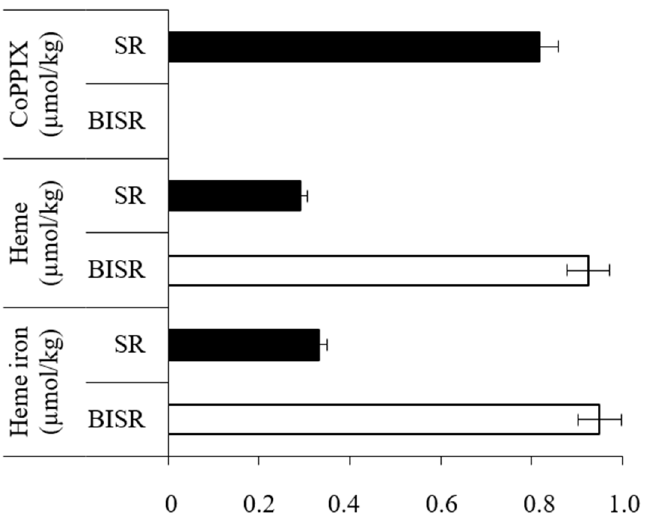
Figure 2. Concentration of CoPPIX, heme and heme iron in BISR and SR samples (µmol/kg of rock sample). Selected ion ( m / z 621) gas chromatogram of CoPPIX and calibration curve for determining the concentration of CoPPIX are presented in Figures S1 and S2, respectively. HPLC-PAD chromatogram of heme is presented in Figure S3A. AED chromatogram of heme is presented in Figure S5. Calibration curves for determining the concentration of heme and heme iron are presented in Figures S4 and S6, respectively. All presented differences are statistically significant (significance level: p < 0.05). Supplementary results of chemical analyses of BISR and SR are presented in Figures S7–S12 and Table S1.